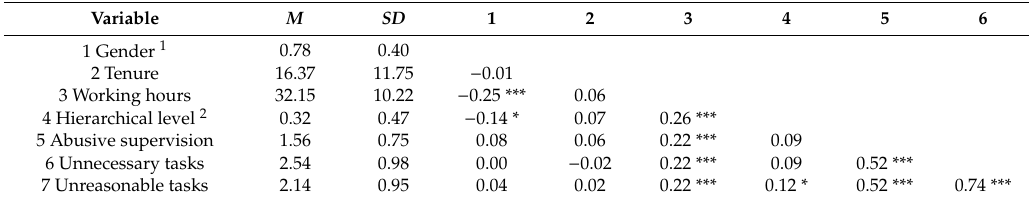
Table 1. Means, standard deviations, and correlations of the study variables.